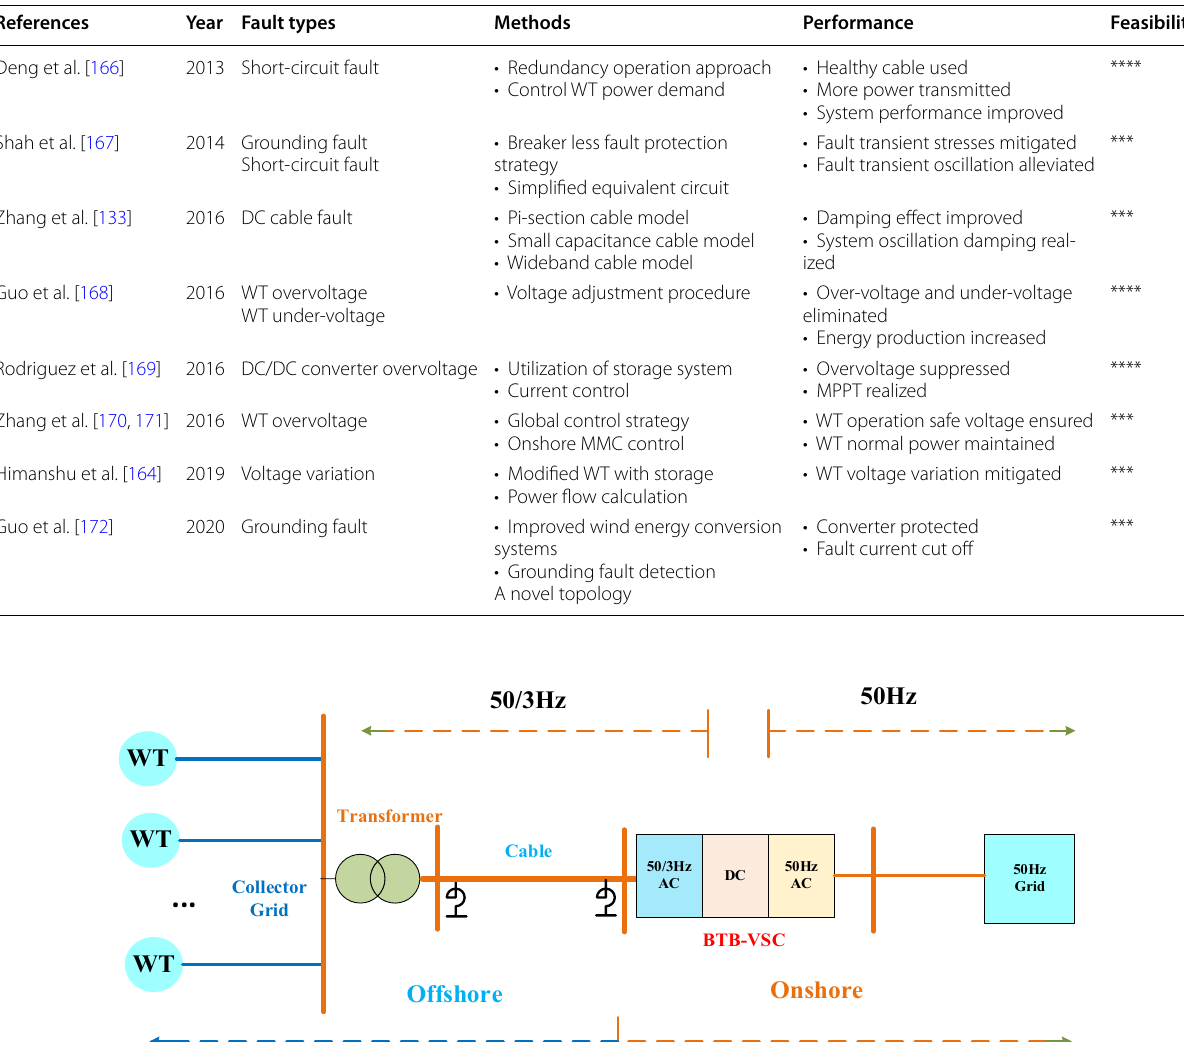
Table 10 FRT technology of ALL-DC OWF system